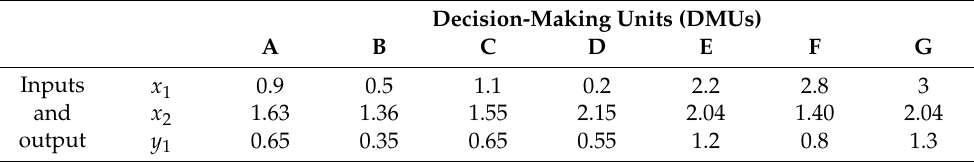
Table 1. The data set.